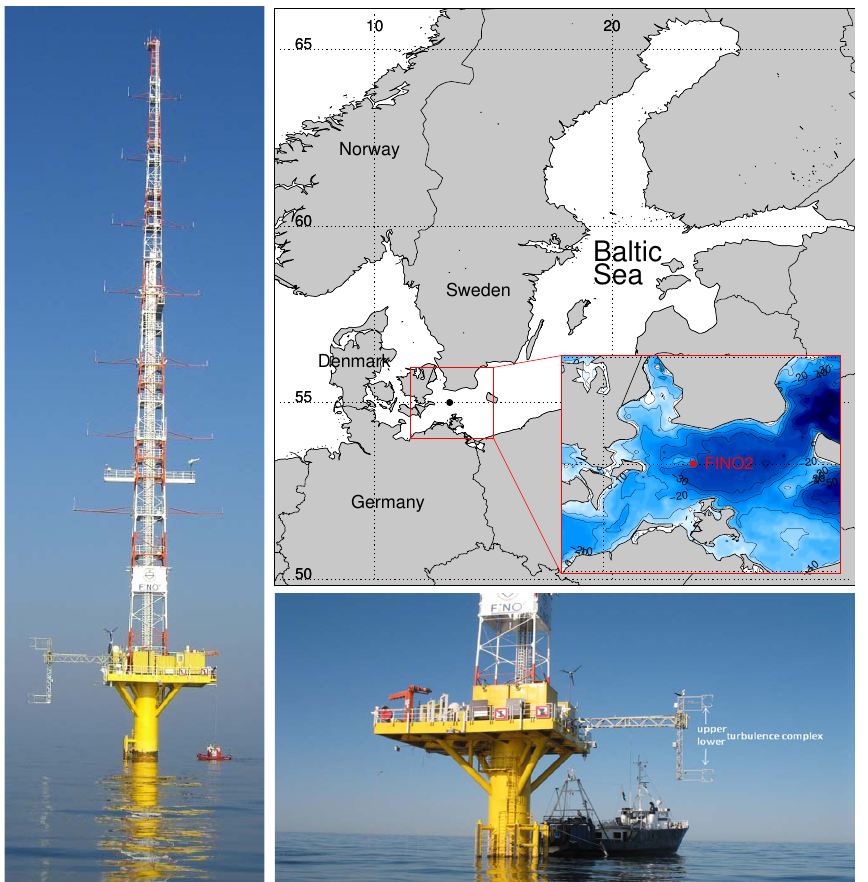
Figure 1. FINO2: position in the Baltic Sea (top, right), the whole mast (left), and the platform with the boom and instrument installation at a height of 6.8 and 13.8m above sea surface (bottom).